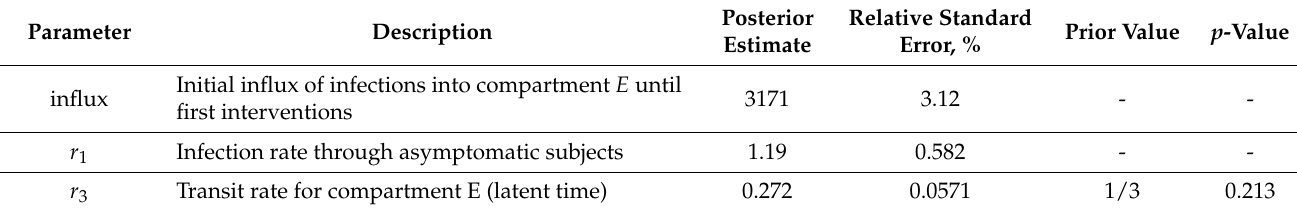
Table A5. Parameter estimates and comparison with average priors. We present estimated parameters of the SECIR model and initial conditions of control parameters and their respective standard errors for Germany. We also perform a formal comparison of estimates and expected priors using t